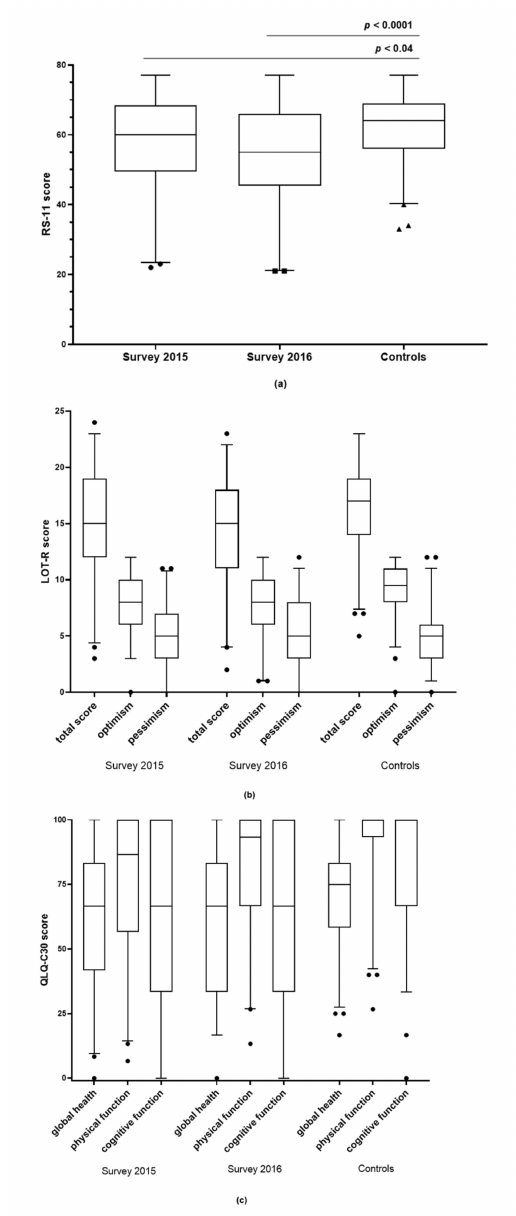
Figure 3. Results of the resilience (RS-11), attitude to life (LOT-R) and quality of life (QLQ-C30) questionnaires from the autoimmune thrombotic thrombocytopenic purpura (iTTP) patients in two surveys (2015 and 2016) and the healthy controls (median, box 25th and 75th percentiles, whiskers 2.5th and 97.5th percentiles, • , (cid:4) , (cid:78) outliers above the 97.5th percentiles or below the 2.5th percentiles). ( a ) RS-11: For the survey in 2015, the median evaluated score was 60 (IQR 49.5–68.5), for the survey in 2016, the score was 55 (IQR 45–66), and for healthy controls, the score was 64 (IQR 56–69). ( b ) LOT-R: In the optimism score, the patients showed significantly worse results than the control group in both rounds (2015 survey p = 0.011, 2016 survey p = 0.006). Within the pessimism score, no large differences between the patients and controls could be detected (2015 survey p = 0.49, 2016 survey p = 0.63). In the first round, no significant difference ( p = 0.088) between the patients and controls was found in the total score, but in the second round, a significant difference ( p = 0.009) between the patients and controls was found. ( c ) QLQ-C30: In the “global health”, “physical function” and “cognitive function” scores, the patients had significantly worse results than the control group in both rounds (2015 and 2016 surveys p <